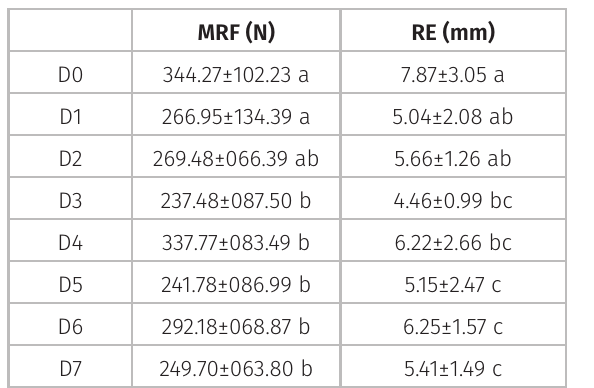
Table I. Mean and standard deviation of the maximum rupture force (MRF) and rupture elongation (RE) of the skin samples from cat cadavers chemically prepared and vacuum packaging for up to 7 days.